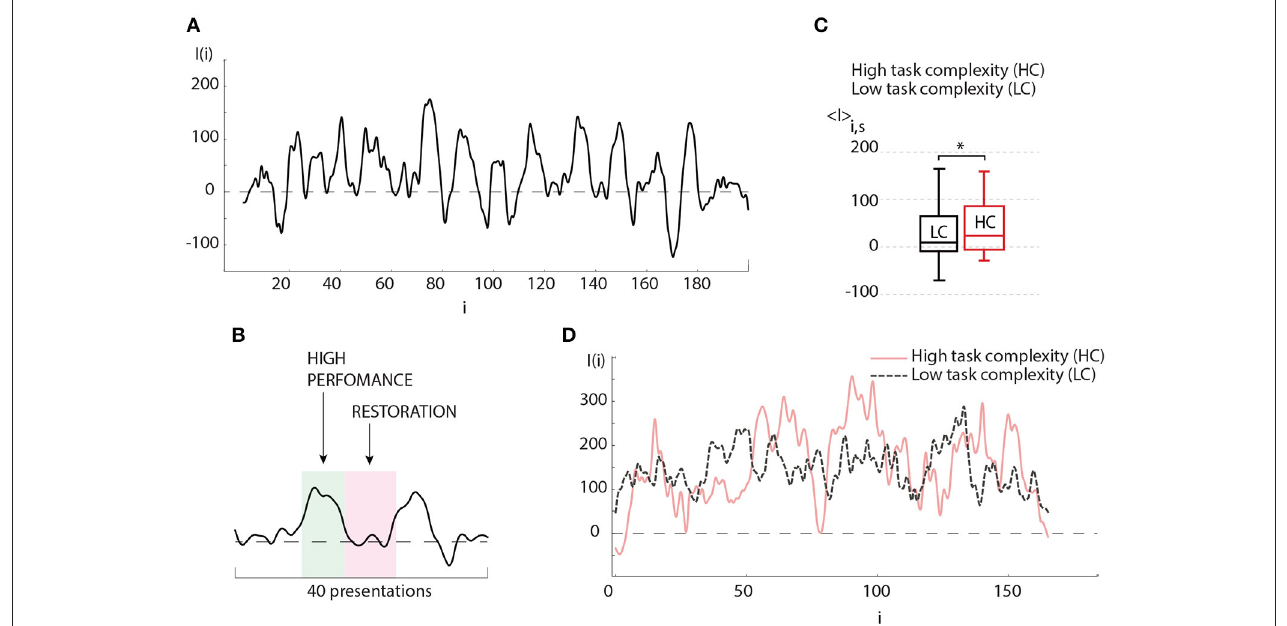
FIGURE 4 | (A) Typical oscillations of the brain response value ( I ) depending on the number of presented visual stimuli during the experimental session. (B) Detailed illustration of a single period of ( I ) oscillations ( ≈ 20 presented stimuli), where “hump” and “hollow” demonstrate the states of high brain performance and restoration, respectively. (C) Average brain response h I i of the subject during experimental session, when images with low degree of ambiguity (LC) ( p = 0.436 by Shapiro-Wilk normality test) and high degree of ambiguity (HC) ( p = 0.434 by Shapiro-Wilk normality test) were presented (session contains 200 presentations) (significant change, n = 10, * p < 0.05 by paired sample t -test). Medians (bars), 25–75 percentiles (box) and outlines (whiskers) are shown. (D) Typical oscillations of the brain response value ( I ) depending on the number of presented visual stimuli during the perception of images of high degree (solid curve) and low degree (dashed curve) of